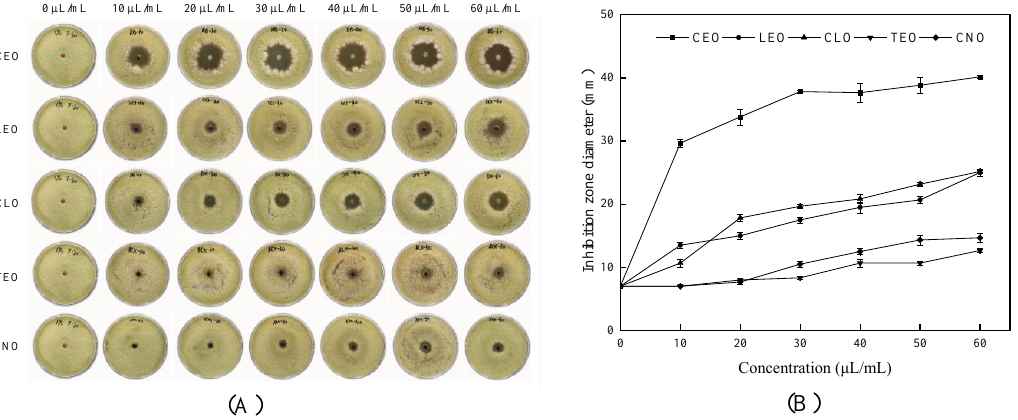
Figure 3. Antifungal effect of different concentrations of five single essential oil (EOs) on strain YQM (CEO, cinnamon EO; LEO, litsea EO; CLO, clove EO; TEO, thyme EO; and CNO, citronella EO): ( A ) growth of strain YQM on 9-cm plate media; ( B ) quantification of inhibition as zone diameter. Values are average values ± standard deviation (biological replicates, n = 3).